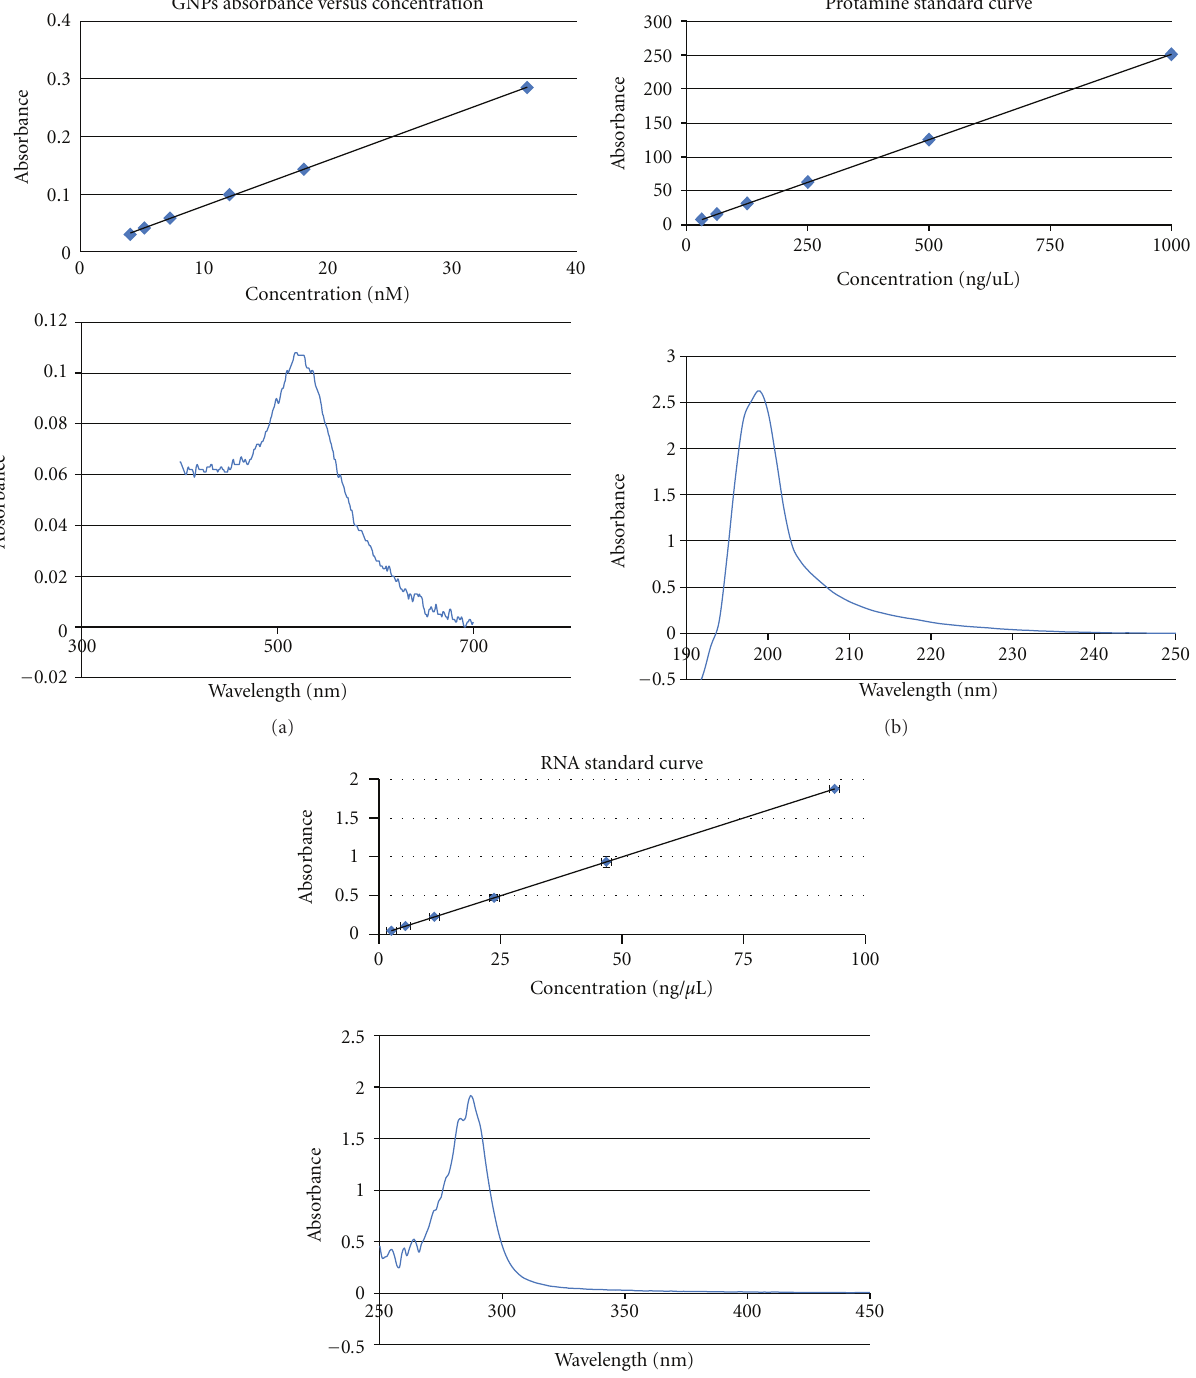
shown to a ff ect the cells’ luminescence by as much as 10 5 – 10 6 over